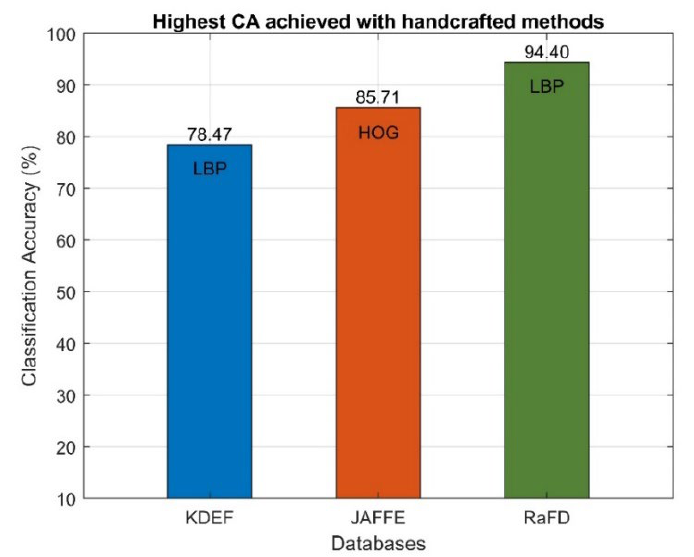
Figure 3. Highest classification accuracy achieved for each database with handcrafted methods.